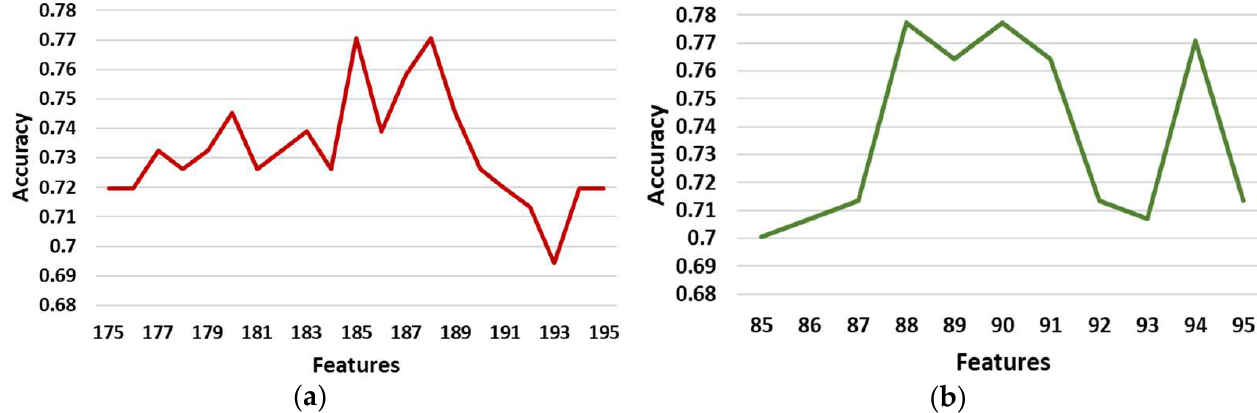
Figure 8. The performance evaluation of ( a ) LR in the range of 175–195 features and ( b ) SVM in the range of 85–95 features. Results are shown with a step size of 1 (one feature added at each step).